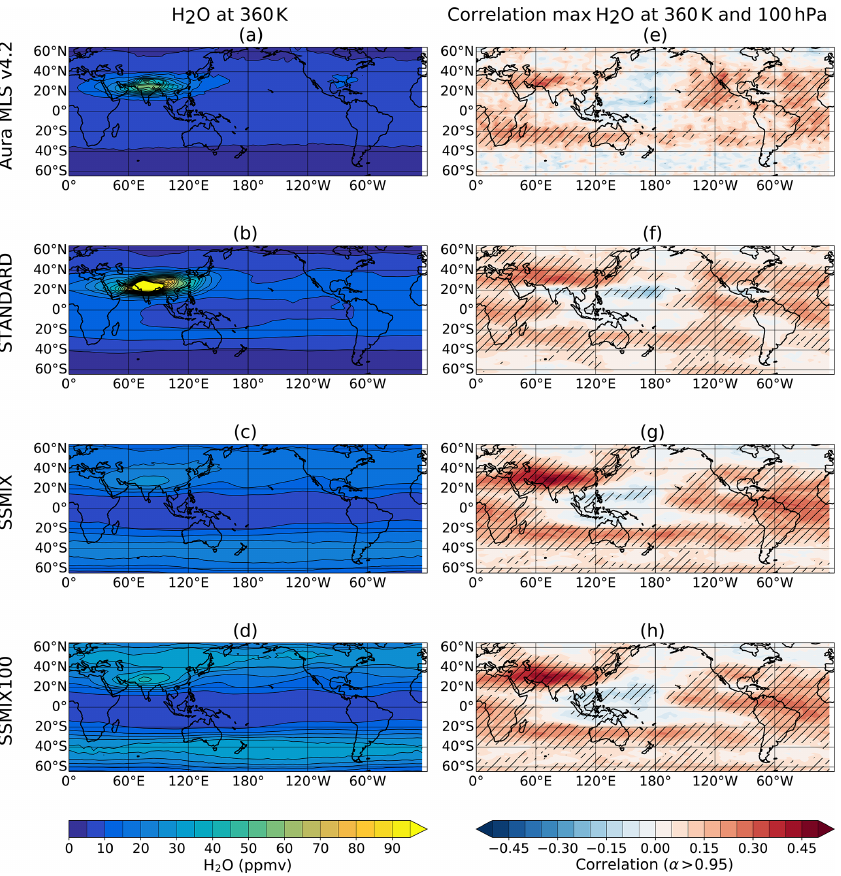
Figure 8. (a–d) Climatology of water vapour at 360K from (a) Aura MLS v4.2 observations, (b) STANDARD, (c) SSMIX and (d) SSMIX initialized with 100ppmv. (e–h) Correlation between the water vapour time series averaged in 60–100 ◦ E, 20–30 ◦ N at 360K and the time series of water vapour at 100hPa at each grid point during boreal summer for (e) Aura MLS v4.2 (f) STANDARD, (g) SSMIX and (h) SSMIX initialized with